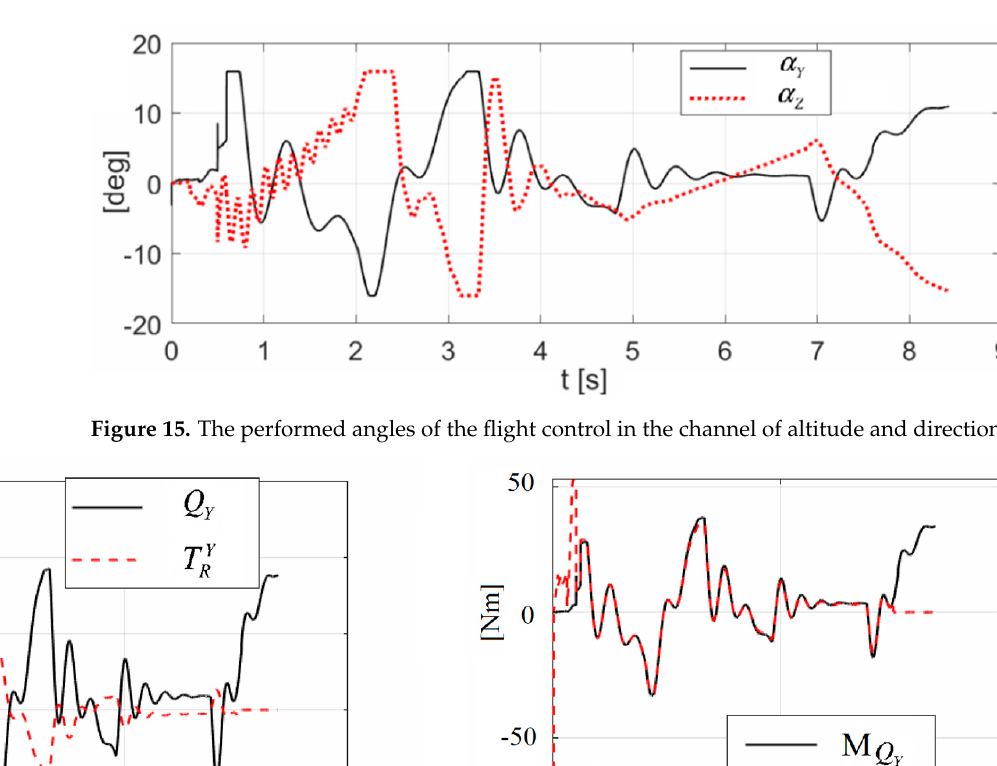
Figure 14. The control errors between the performed and set flight trajectory.